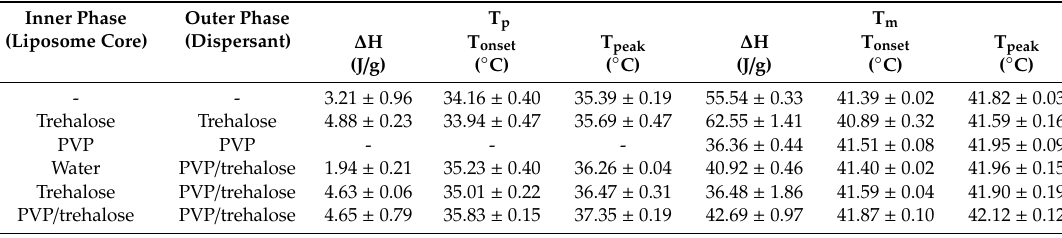
Table 3. Thermotropic behavior of DPPC in the lamellar phase rehydrated in the presence of water or a solution of trehalose (5:1 molar ratio), PVP, or a mixture thereof: The same excipients were also added to the rehydrated lamellar